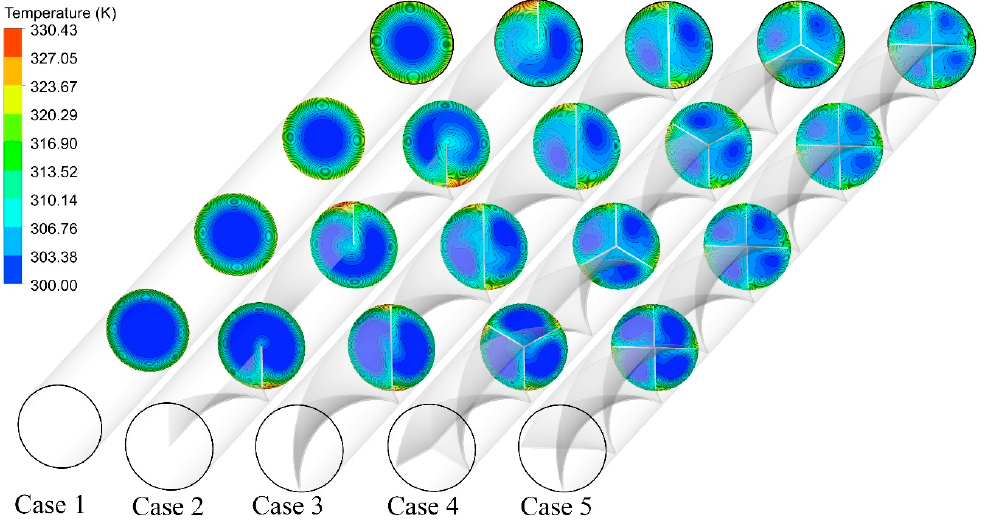
Figure 8. Cross-sectional temperature contours for the captured cases at Re = 250 and ϕ = 0%. The analysis of radial and tangential velocity provides details about the role of multiple semi-twisted tape addition on the intensity of secondary flow. As seen in Figure 9, negative radial velocity is found in the vicinity of the twisted tape, while positive radial velocity is observed in the regions far from the twisted tape. Two low and two high radial velocity regions are detected in the case of N = 1, while four low and four high radial velocity regions are found in the case of N = 4. This indicates that there is a continuous movement in the fluid from the wall to the core and conversely from the core to the wall. It is also inferred that the value of radial velocity is higher in the case of higher numbers of semi-twisted tape (N = 4) as compared to that of a single semi-twisted tape case. This is the result of higher rotational movement, more centrifugal action, more efficient interruption in the thermal boundary layer, and a higher amount of swirl motion in the flow.